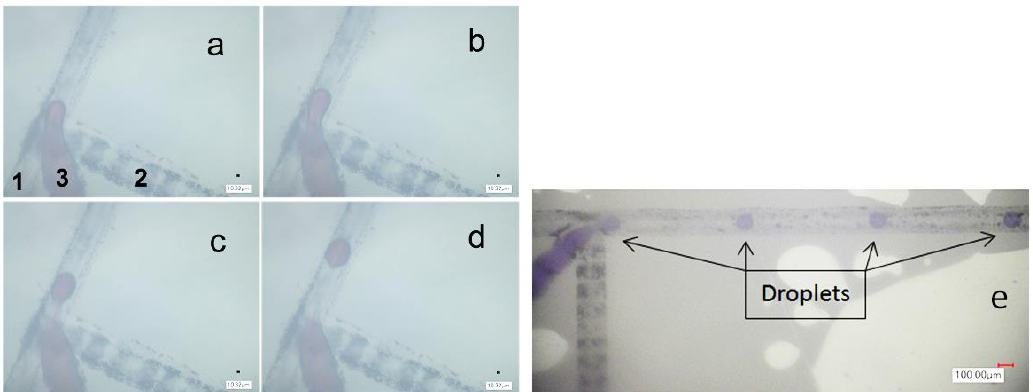
Figure 7. Droplet breakup in the MDTJ from ( a ) to ( d ) (this channel belongs to channel in Figure 4a) Channels 1 and 2 are oil ( 1.1 mL/h ) and Channel 3 is the water at 0.3 mL/h. ( e ) Real photo to illustrate the uniformity of droplet distribution inside the channel at 3 mL/h oil flow rate and 0.3 mL/h water flow rate with scale bar 100 μm .